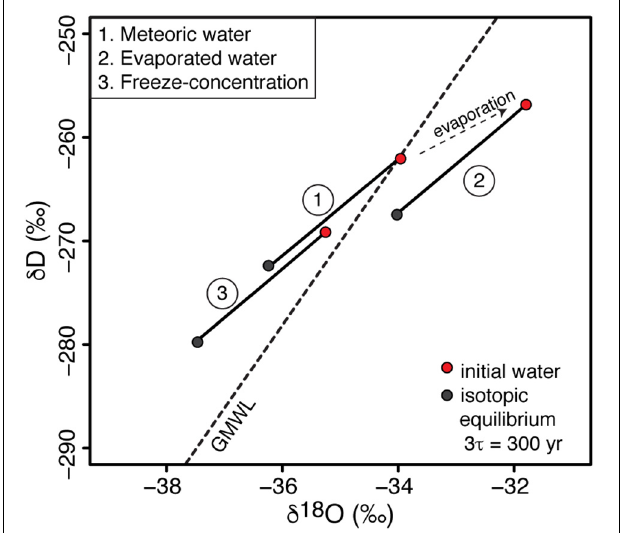
FIGURE 7 | Effects of water input with various δ D- δ 18 O signatures (i.e., evaporated water, meteoric water, cryo-freezing water) on the δ D- δ 18 O composition of well-sealed ice-covered lakes. For this example, the mixing rate is 1% and isotopic steady-state is reached in c. 300